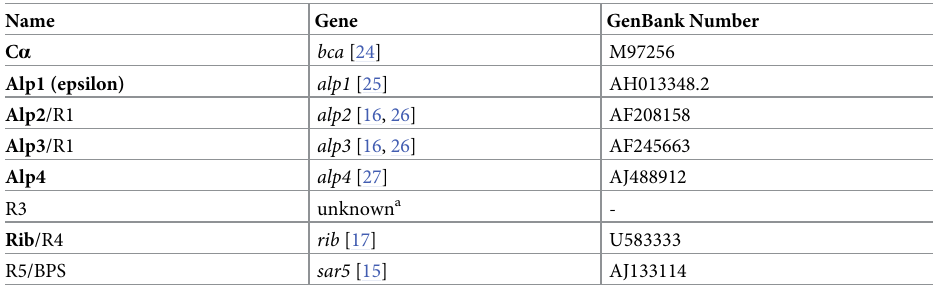
Table 1. Surface-proteins of